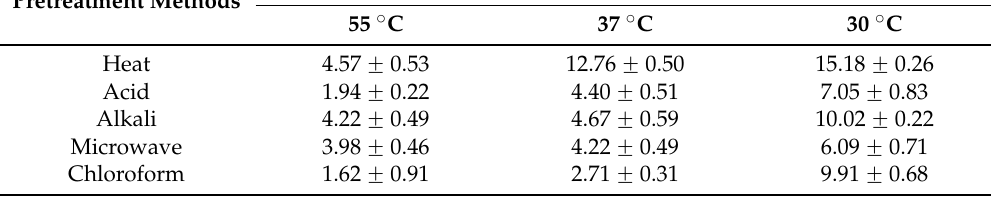
Table 1. Hydrogen production (mmol/L) for different pretreatment methods across different fermentation temperature